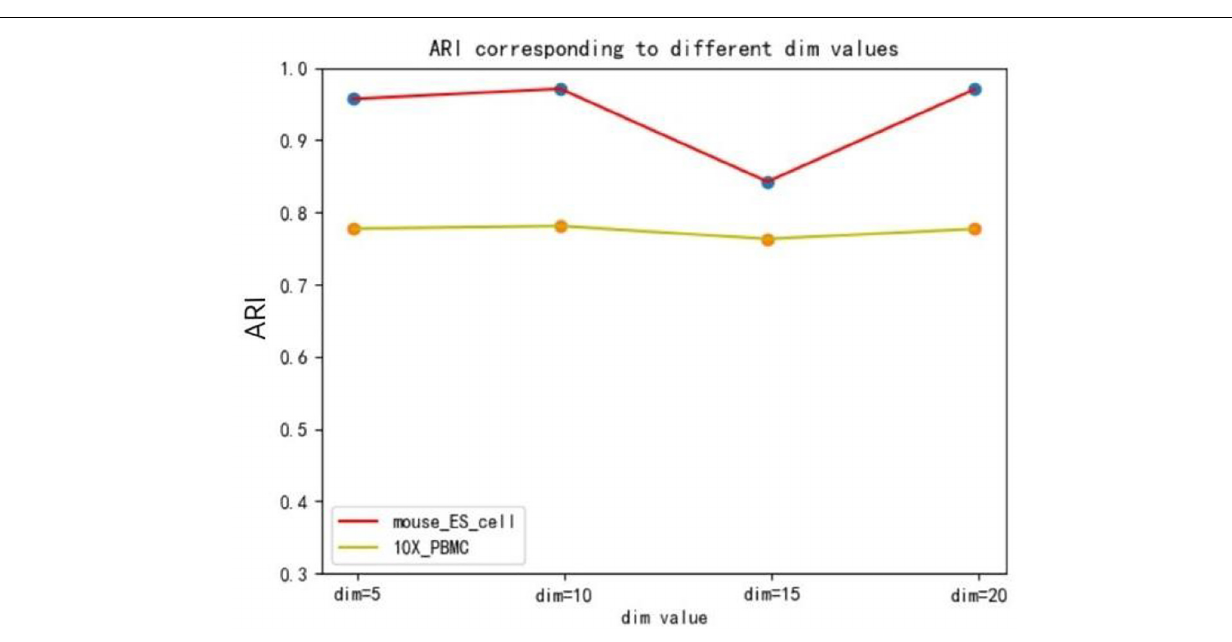
FIGURE 4 | The influence of hidden layer nodes on SCDRHA under adjusted Rand index